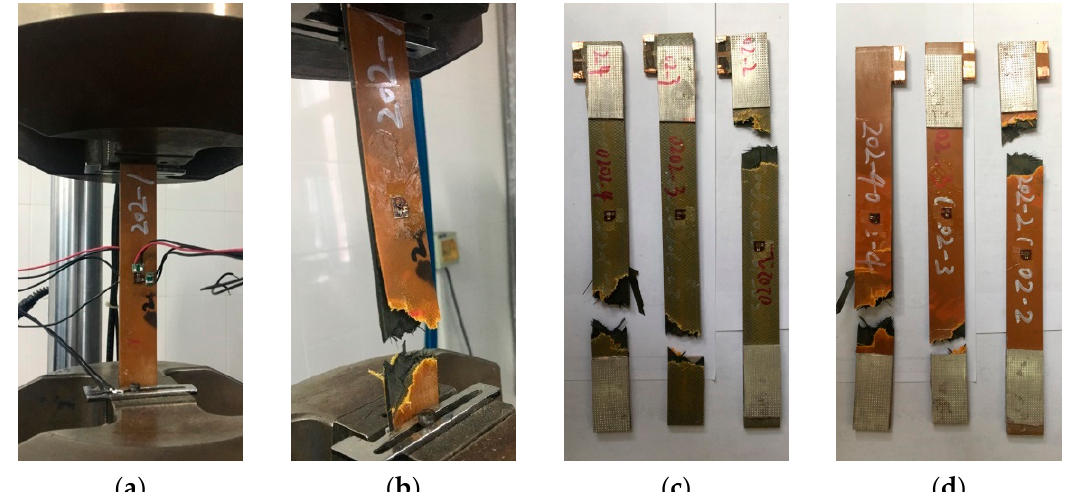
Figure 11. Specimens used in the measurement of mechanical properties: ( a ) specimen in the test; ( b ) specimen after the test; ( c ) front of specimen; ( d ) back of specimen.